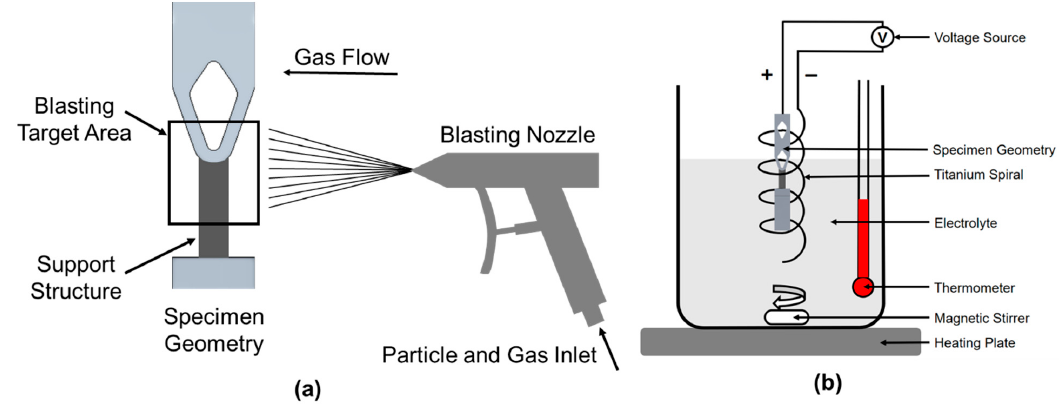
Figure 1. Schematic representation of the ( a ) general blasting process and ( b ) electrochemical polishing .